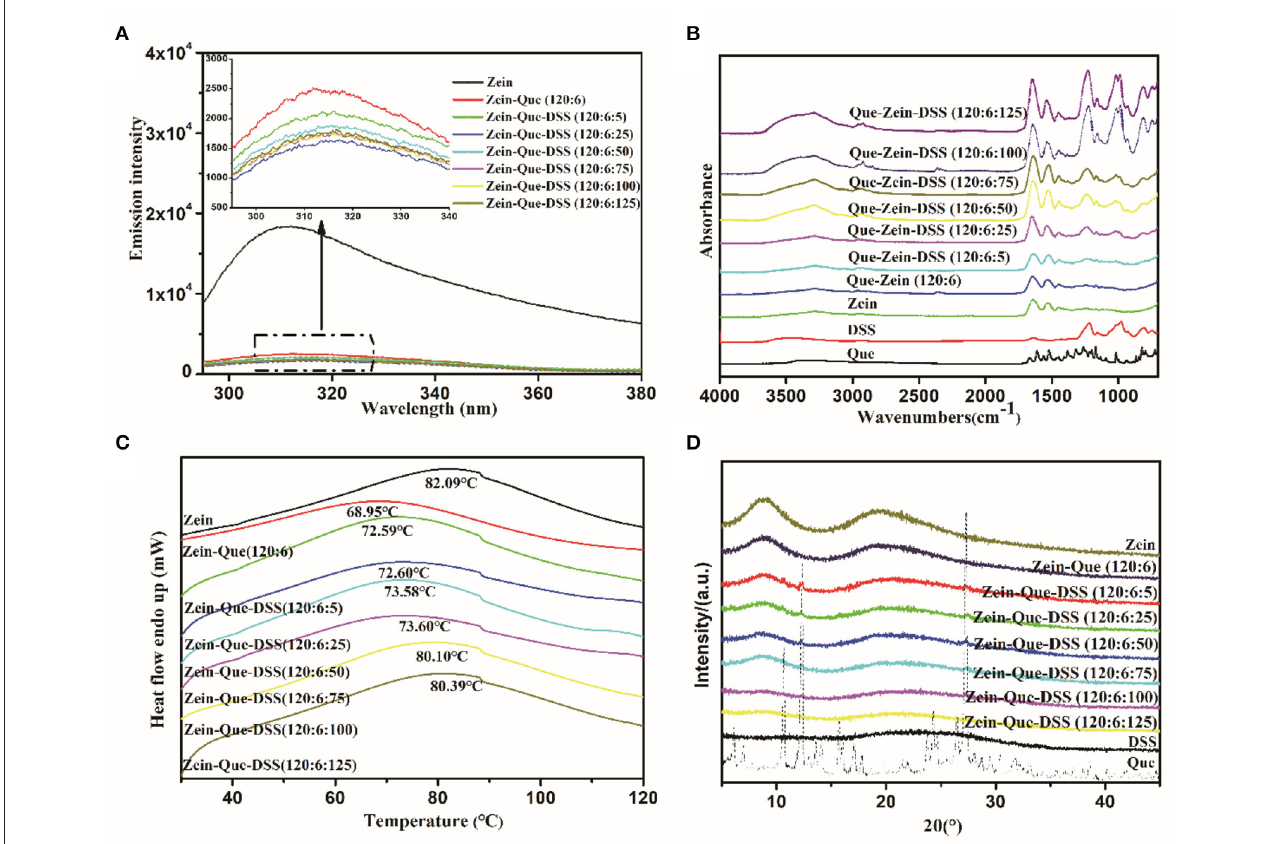
FIGURE 3 | Fluorescence spectra (A) , FTIR (B) , DSC (C) , and XRD (D) of Que, Zein, DSS, Zein-Que nanoparticles, and Zein-Que-DSS complex nanoparticles.